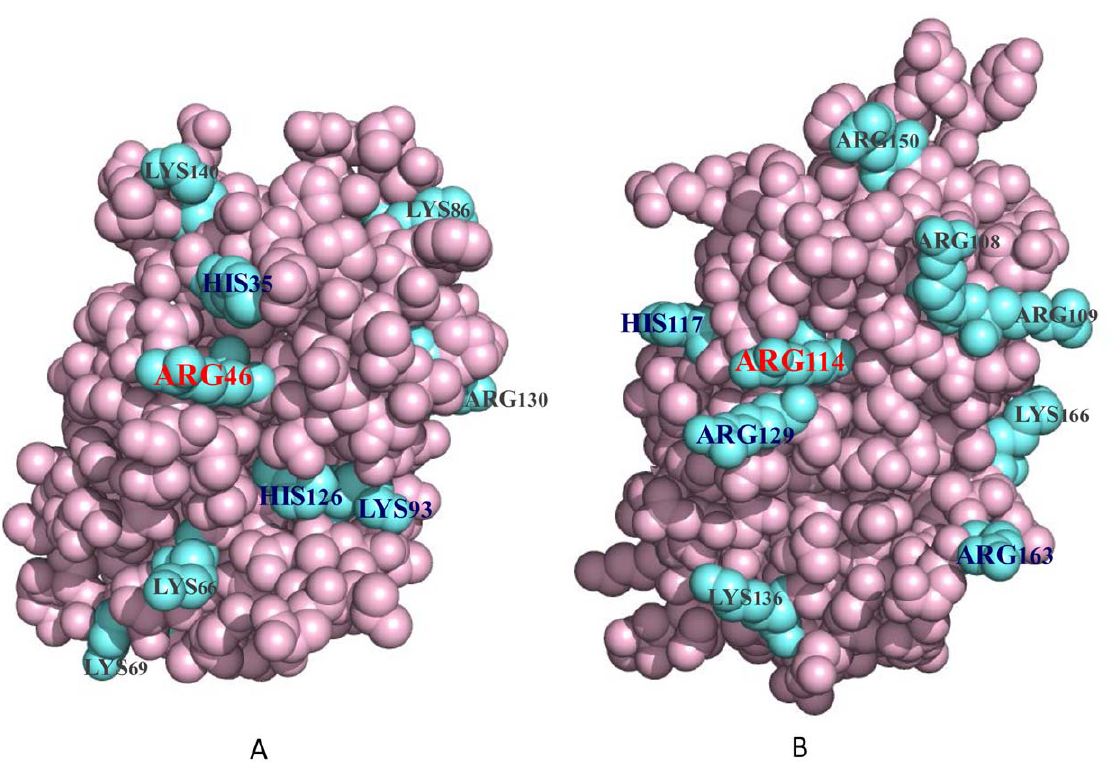
Figure 9. The predicted spatial structures of gC1q domains. The gC1q domains from CfC1qDC (A) and globular head B of human complement C1q (B) were predicted by SWISS-MODEL program. The blue molecules represent the cationic amino acid residues on the surface of gC1q domains.